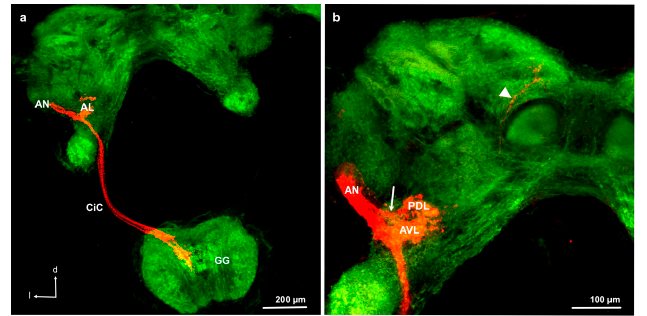
Figure 3. Antennal projections in Libellula depressa nymph (F0 instar). ( a ) Antennal nerve (AN) projections to the antennal lobe (AL) and through the circum-esophageal connective (CiC) to the gnathal ganglion (GG). ( b ) Bipartite AN entering the AL (arrow indicating dorsal AN branch), innervating the posterior dorsal (PDL) and anterior ventral (AVL) lobe, and a fiber projecting to the protocerebrum (arrowhead). d dorsal, l lateral. Maximum z-projections over 142 μ m ( a ) and 70 μ m ( b ) of confocal sections with Microruby stained axons in red and background staining with the anti-synapsin antibody in green.